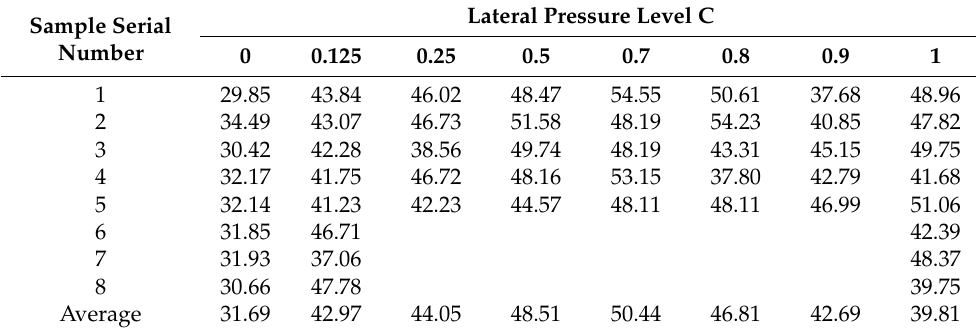
Table 4. ECC ultimate strength test results under different lateral pressures